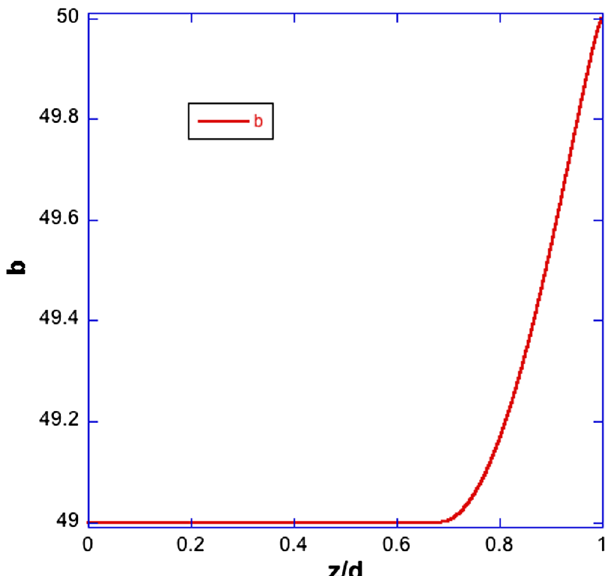
FIG. 4. Dimensionless potential (red, left scale) and electric field magnitude. The electric field (blue, right scale) peak is about 5 V = d, 30 MV = cm, EX for the HE regime of Sec. II B 3 and Δ I ¼ 0 . 4 MA. See the text for the meaning of the symbols.